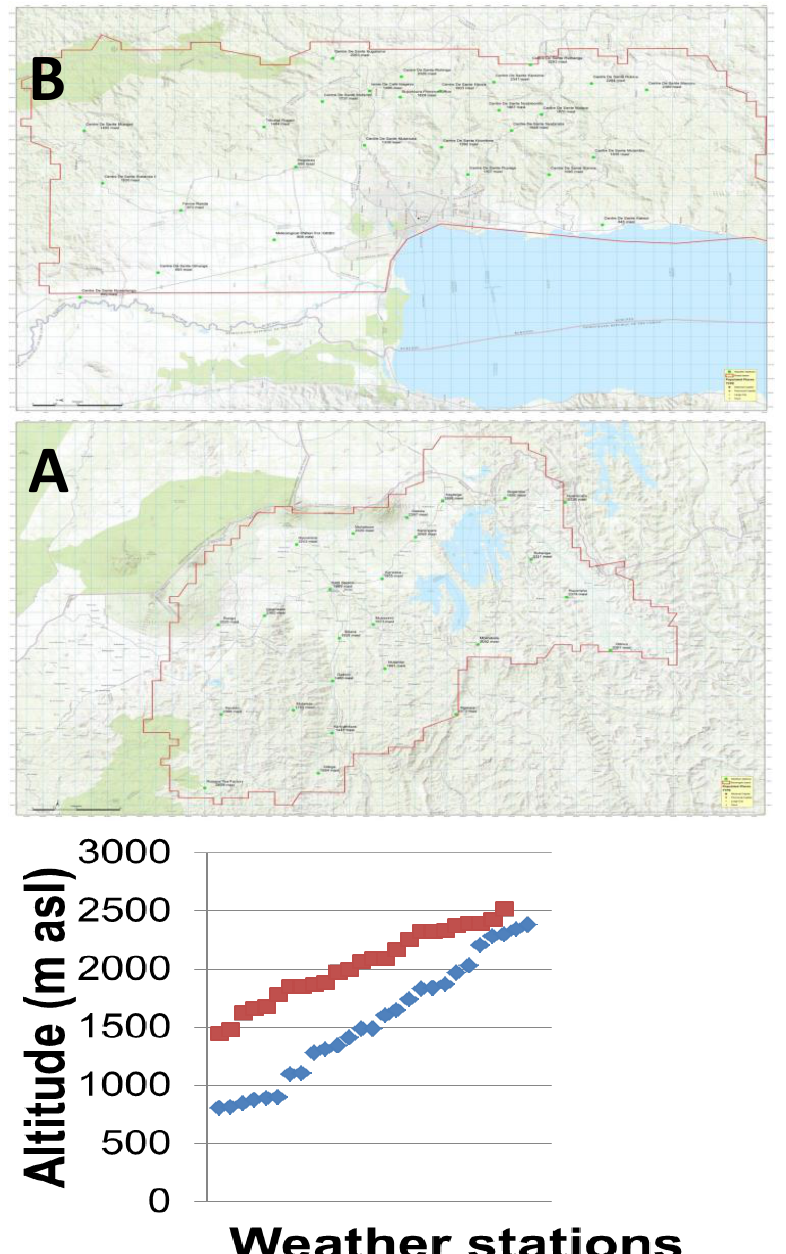
Figure 6: Altitude and location of weather stations: A) Rwanda: Ruhengeri - red points: 1,400-2,500 masl B) Burundi: Rusizi valley - blue points: 800-2,500 masl